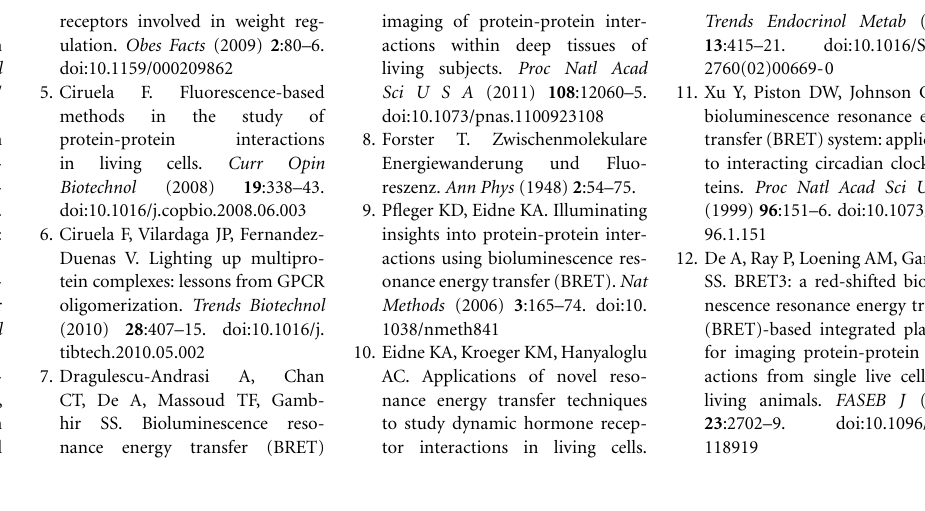
FIGURE 2 | Bioluminescence resonance energy transfer performance in deep tissue imaging experiments . (A) Upper panel represents mouse images comparing improvements in the signal output from lungs. Mammalian cells engineered for equivalent over-expression of donor alone (RLuc8 or RLuc8.6) or BRET proteins (mOrange-RLuc8 orTurboFP-RLuc8.6) as marked, were compared. Note the photon output values in the reference color scale bars. Highest signal output from same number of cells placed within lungs was noted withTurboFP-RLuc8.6 BRET protein imaged with Clz substrate. (B) Schematic illustration of the most successful BRET format tested for monitoring the rapamycin induced FRB-FKBP12 association. (C) Representative bioluminescence images of nude mice with accumulated